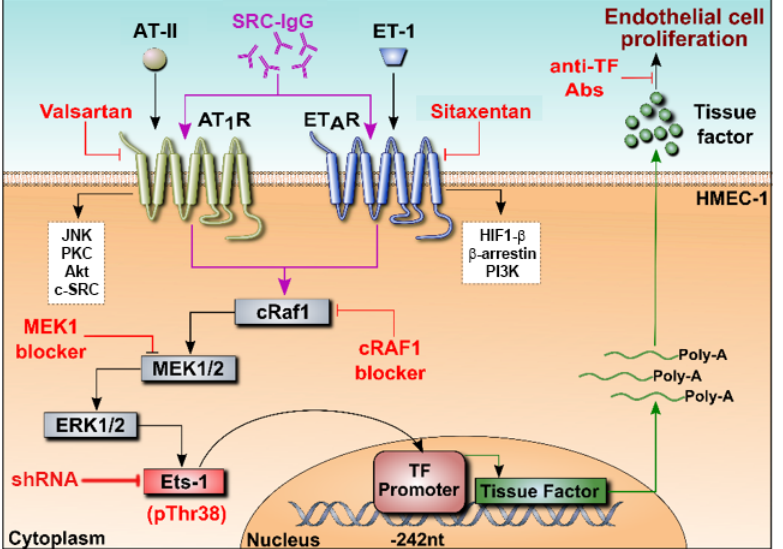
Figure 5. Proposed intracellular cascade following AT 1 R and ET A R activation by SRC-IgG. Binding of SRC-IgG to the receptors triggers the activation of cRaf1, MEK, ERK1/2 and, in turn, of Ets-1, through phosphorylation of its Thr38. Once activated, Ets-1 binds to the promoter of TF, triggering its expression (mRNA and protein). This intracellular pathway results in endothelial cell proliferation, inducing obliterative vasculopathy in SSc patients.